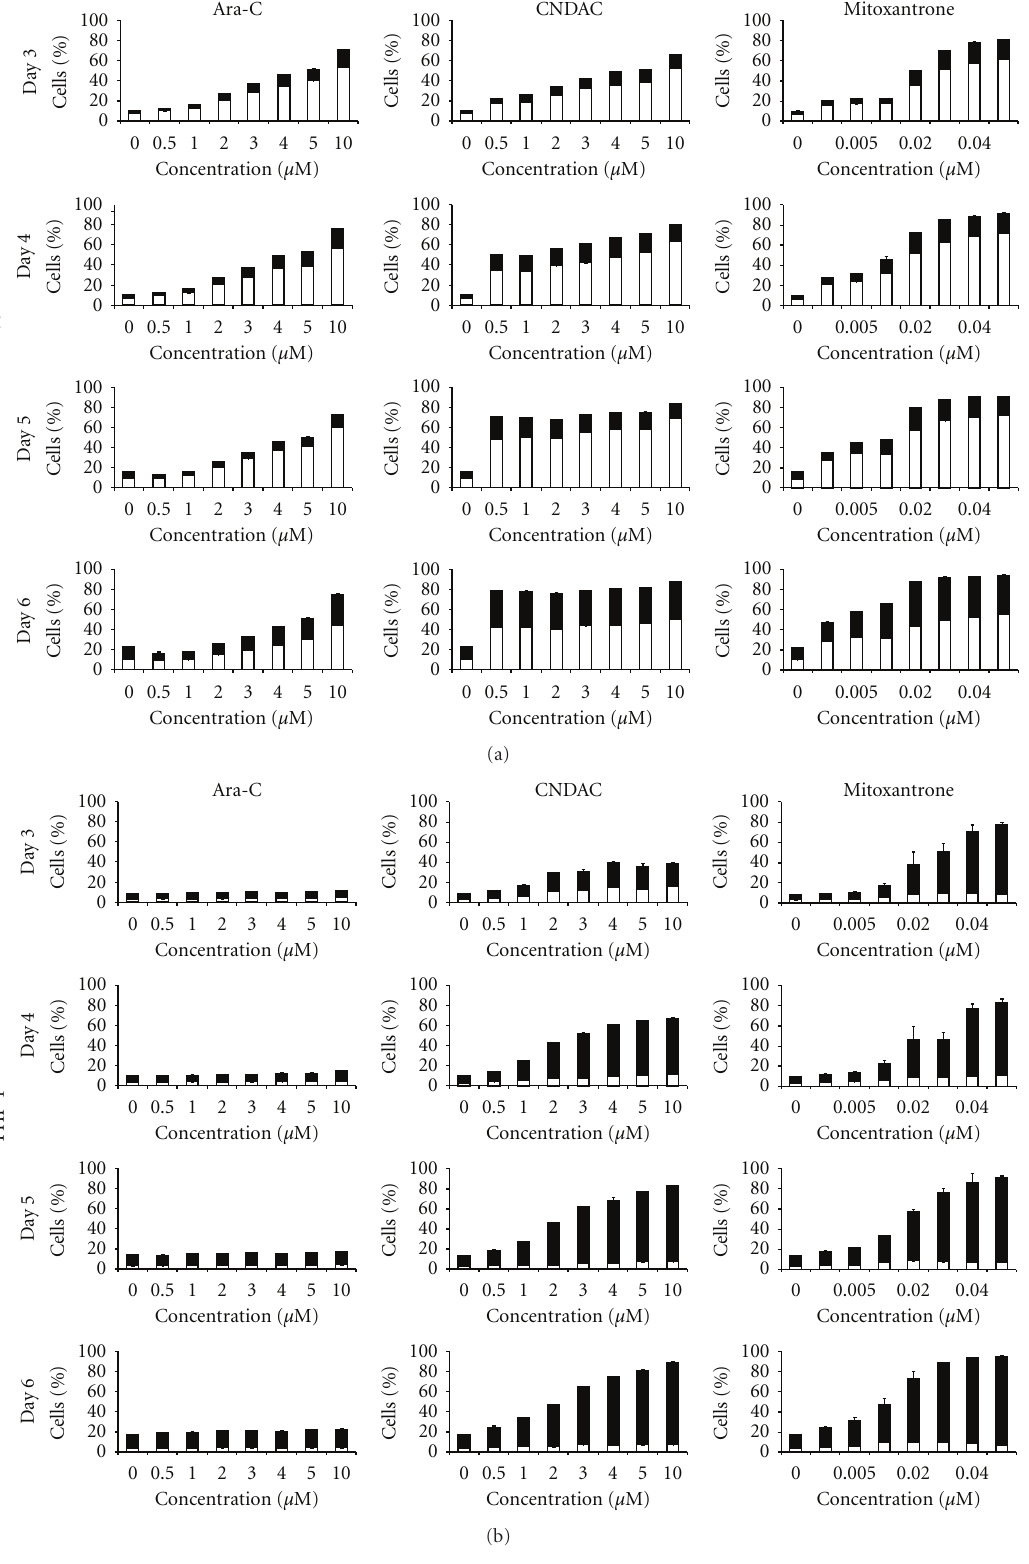
Figure 3: Apoptosis analysis of HL-60 and THP-1 cells. Plots represent distribution of (cid:2) % early and (cid:3) % late apoptotic (a) HL-60 and (b) THP-1 cells treated with ara-C, CNDAC, or mitoxantrone as determined by 7-AAD/Annexin V staining. Cells were plated at 0.5 × 10 6 cells/mL, in triplicate, and drug-treated for 3, 4, 5, and 6 days. The entire bar represents total dead